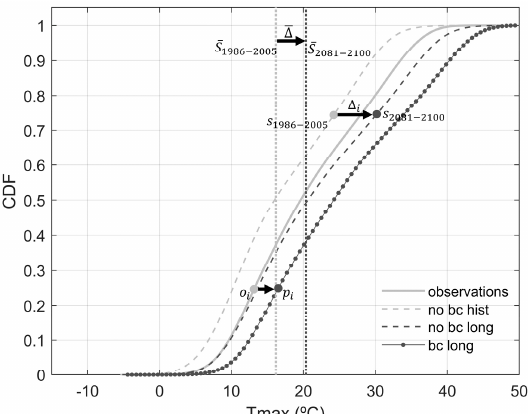
Figure 2. Graphical scheme of the bias correction (bc) of maximum temperature (Tmax, °C) for Madrid for only the long-term future. Cumulative distribution function (CDF) of the observations, simulations with no bias correction of the historical and long-term future periods (no bc hist and no bc long, respectively), and bias correction of the long-term future period (bc long). Vertical lines show the mean values of historical and long-term future simulations before bias correction.